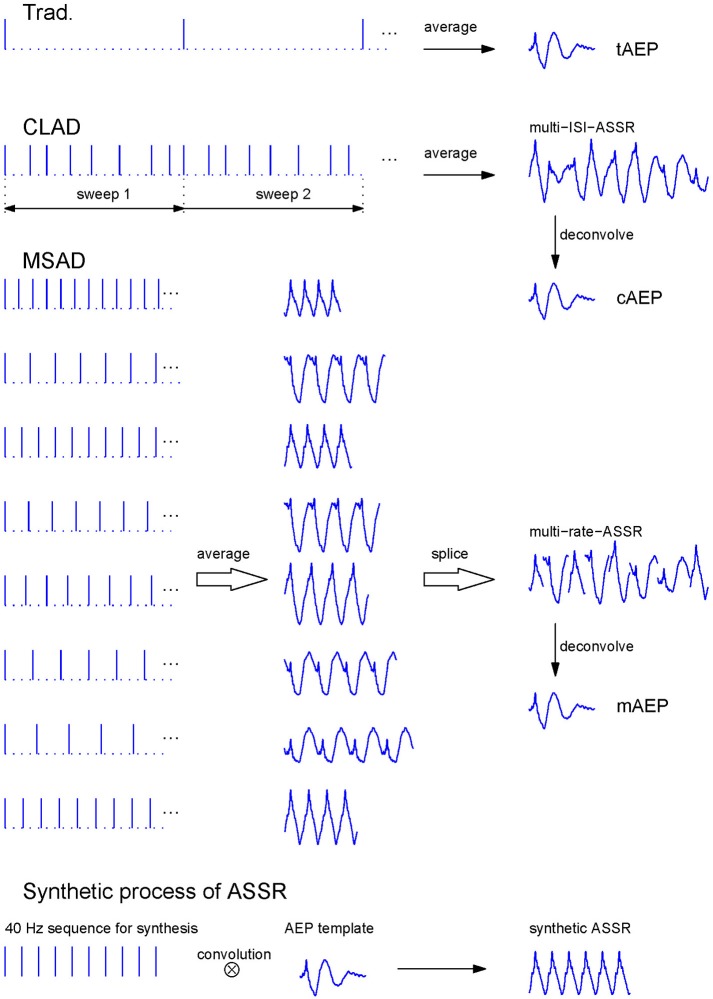
Stimulus sequences, transient AEPs extraction for the Trad., CLAD, and MSAD paradigms, and synthetic process of ASSR by transient AEP template. The Trad. sequence comprises stimuli presented with a large ISI of 204.8 ms (the 1st row). The tAEP was the averaged response to every stimulus. The CLAD irregular sequence (the 2nd row) consists of a number of reduplicative stimulus sweeps with 8 ISI-jittered stimuli each, where ISIs = {16.00, 28.80, 19.20, 27.20, 24.00, 32.00, 36.80, 20.80} ms. Responses elicited by sweeps of stimuli were averaged to gain the multi-ISI-ASSR that was then being deconvolved to obtain the cAEP. The MSAD evenly-spaced stimulus sequence (the 3rd ~10th rows) includes 8 isochronic stimulus sequences with the same ISIs as those in CLAD. These rate-jittered sequences evoked 8 ASSRs. Eight averaged one-cycle ASSRs were spliced one by one into the multi-rate-ASSR similar to multi-ISI-ASSR in CLAD. The mAEP was reconstructed from the multi-rate-ASSR. The bottom showed the synthetic process of ASSR that was the convolution of the transient AEP template with the 40 Hz stimulation sequence with constant ISIs. In this study, three transient AEPs (i.e., tAEP, cAEP, and mAEP) were all used as templates to synthesize corresponding ASSRs, respectively. These synthetic ASSRs will be separately compared with the recorded ASSR in the subsequent analysis.